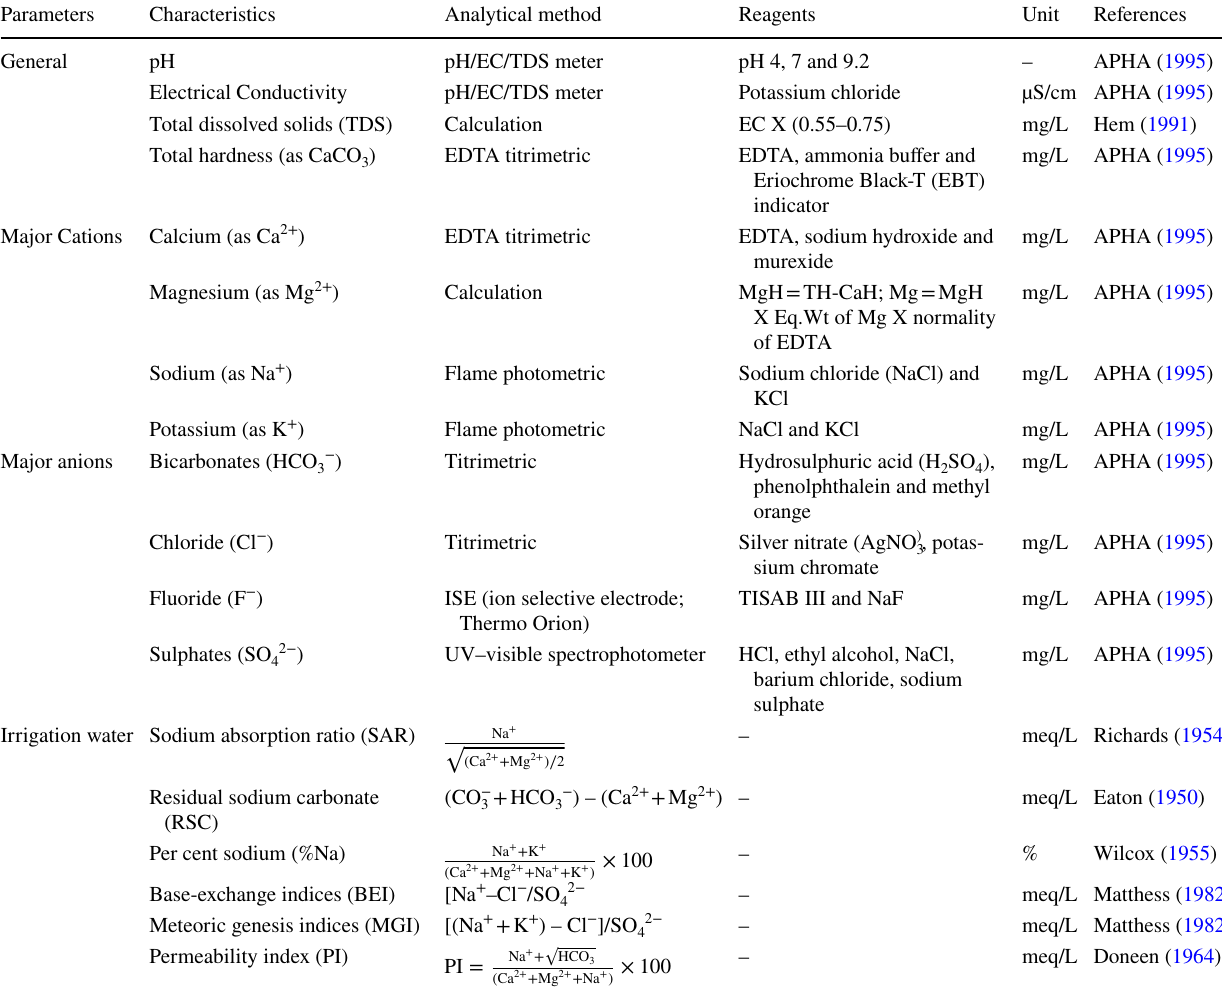
Table 1 Instrumental, titrimetric and calculation methods used for chemical analysis of water samples in Mothkur region, Telangana State